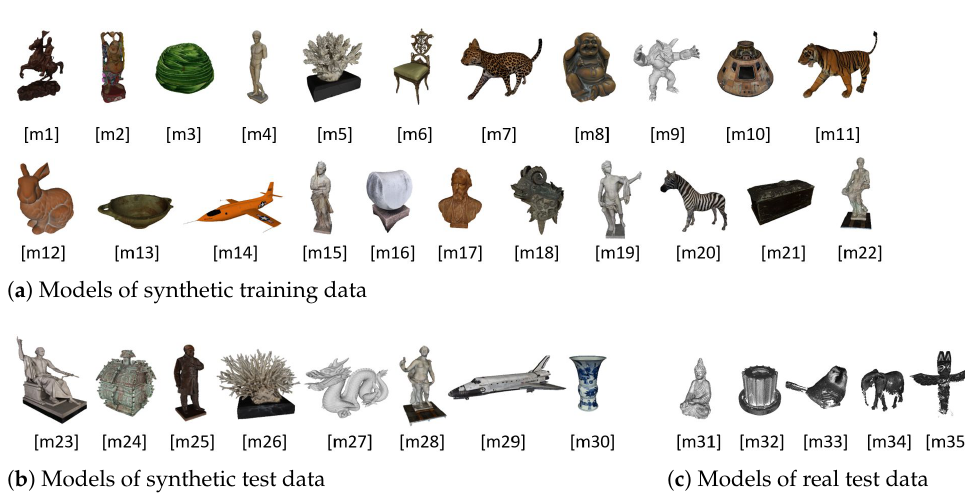
Figure 10. 3D models that have been used to create the synthetic and real datasets. ( a ) shows the models on which the synthetic training scenes are based on; ( b ) shows the models of the synthetic test scenes; ( c ) shows the models that result from the captured real